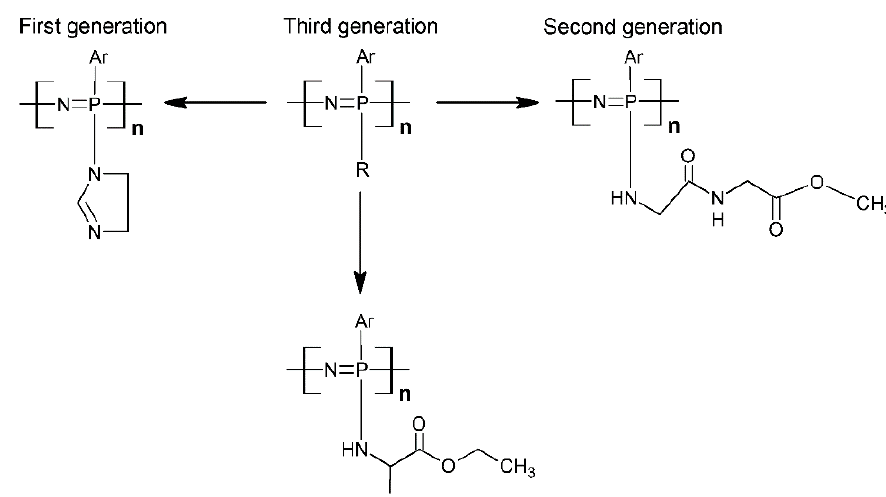
Figure 20. Evolution of design of polyphosphazenes for bone regeneration.